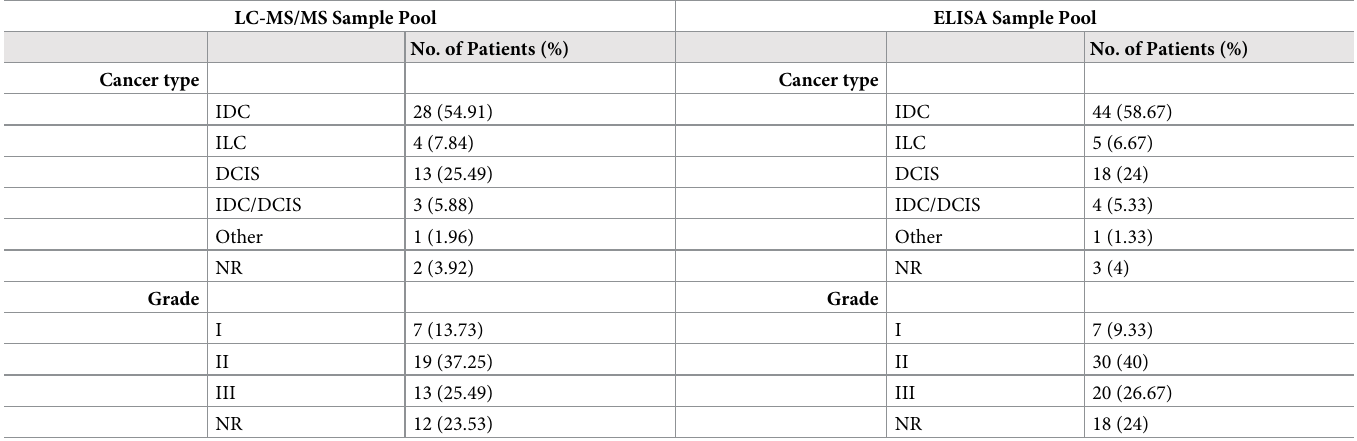
Table 3. Distribution of breast cancer types and grade designations.